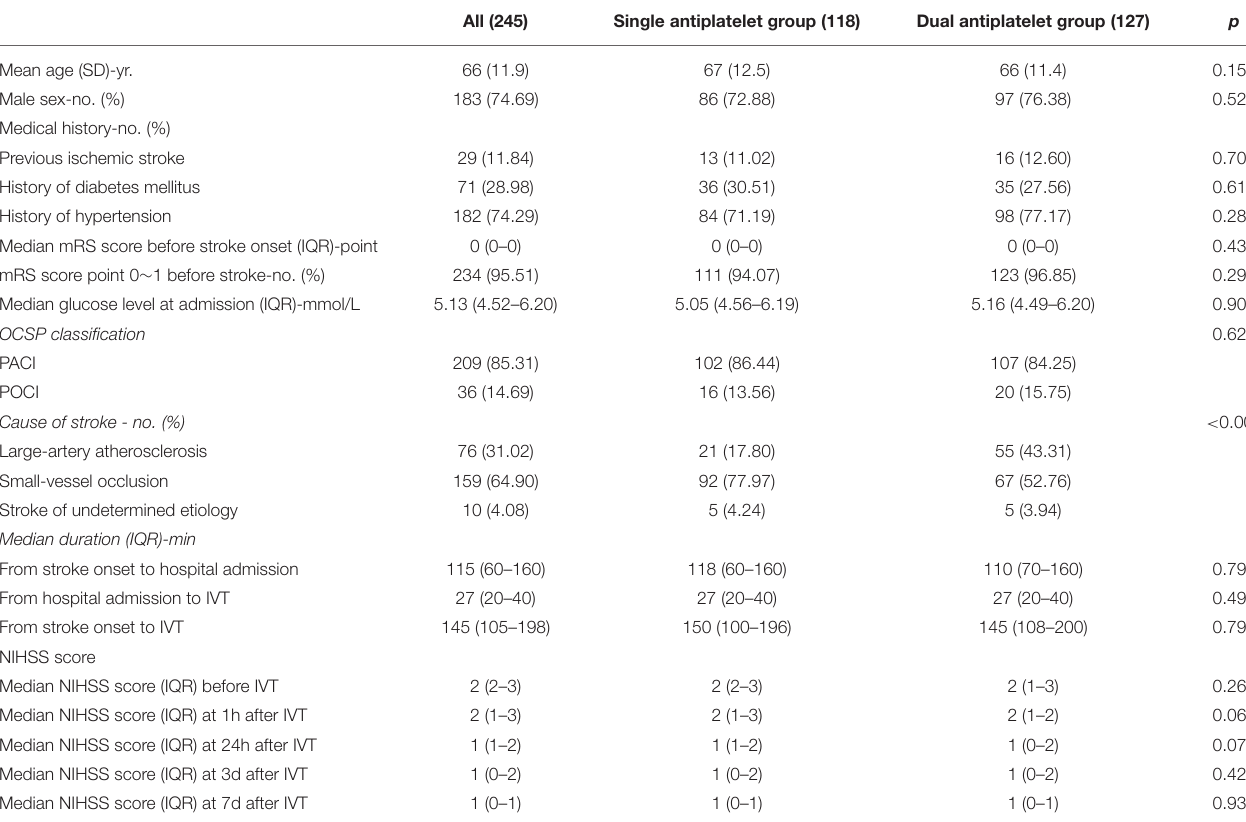
TABLE 1 | Baseline demographic characteristics.